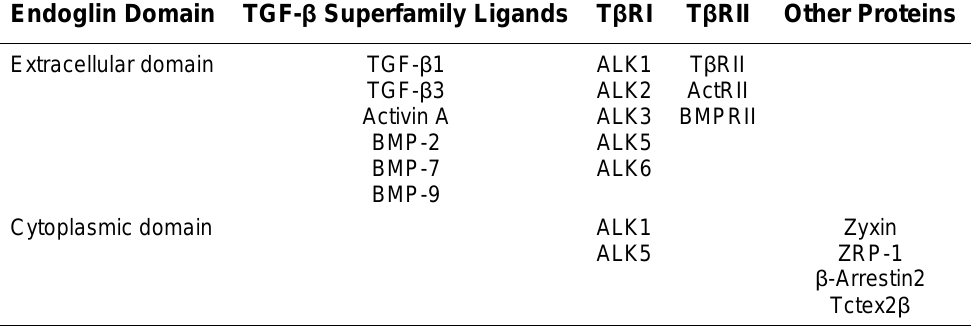
A Summary of Endoglin-Binding